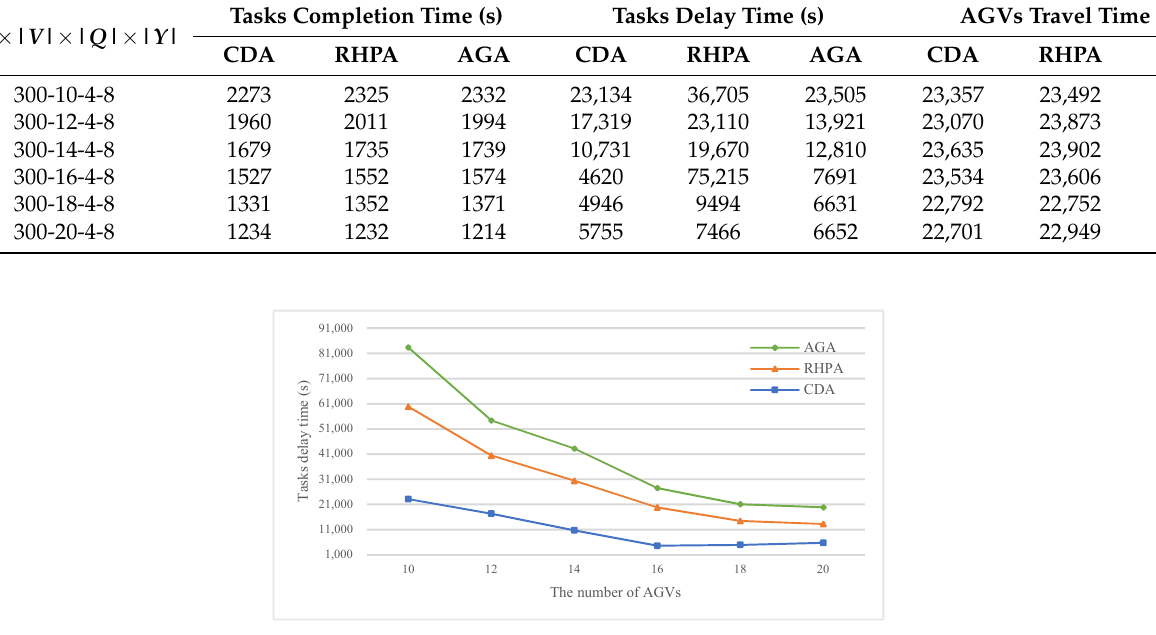
Figure 11. Curve of task delay time with the number of AGVs.